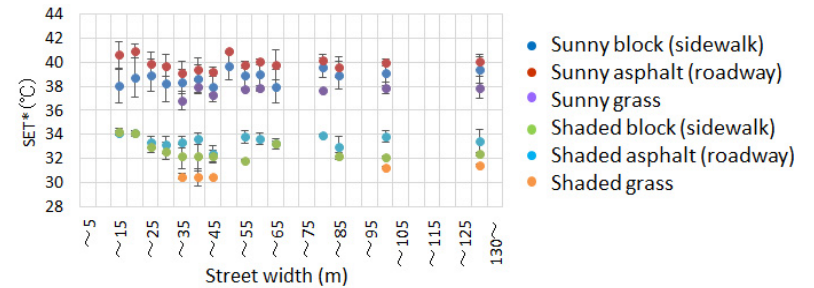
Figure 15. Relationship between street width and SET* at 1.5 m height at 1:00 p.m. on 5 August 2019 on boulevard (southwest-northeast road). The plot is the averaged value, and the vertical bar on each plot is the standard deviation in the street width section.